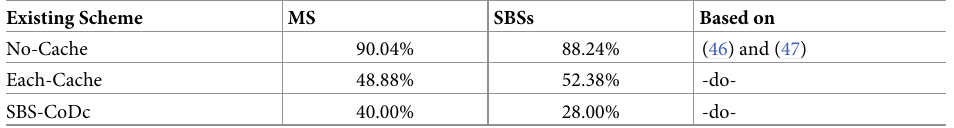
Table 5. Percentage improvement of average throughput of MSs and SBSs.